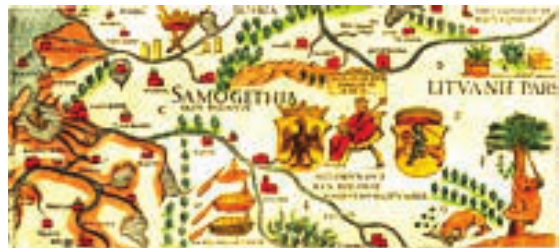
Fig. 3. Ships in the river Nemunas on the fragment map by Olaf Magnus